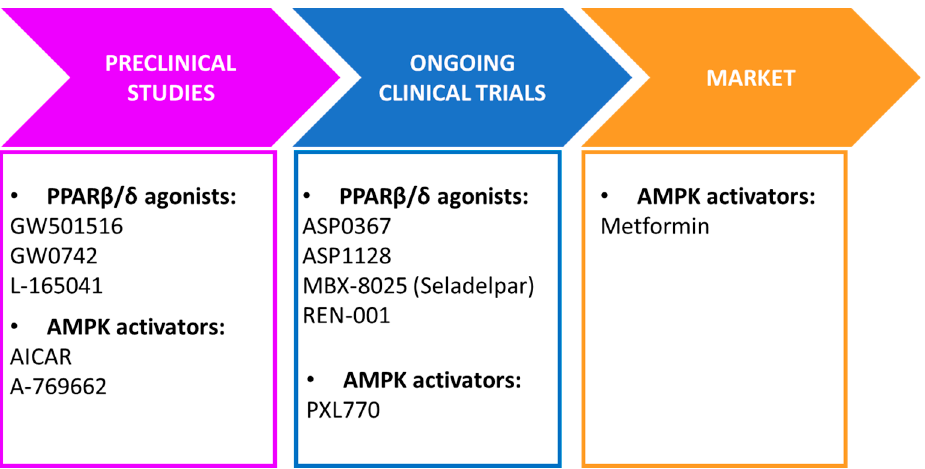
Figure 1. PPAR β / δ agonists and AMPK activators and current status in clinical pipeline. AICAR, 5-aminoimidazole-4-carboxamide ribonucleoside.